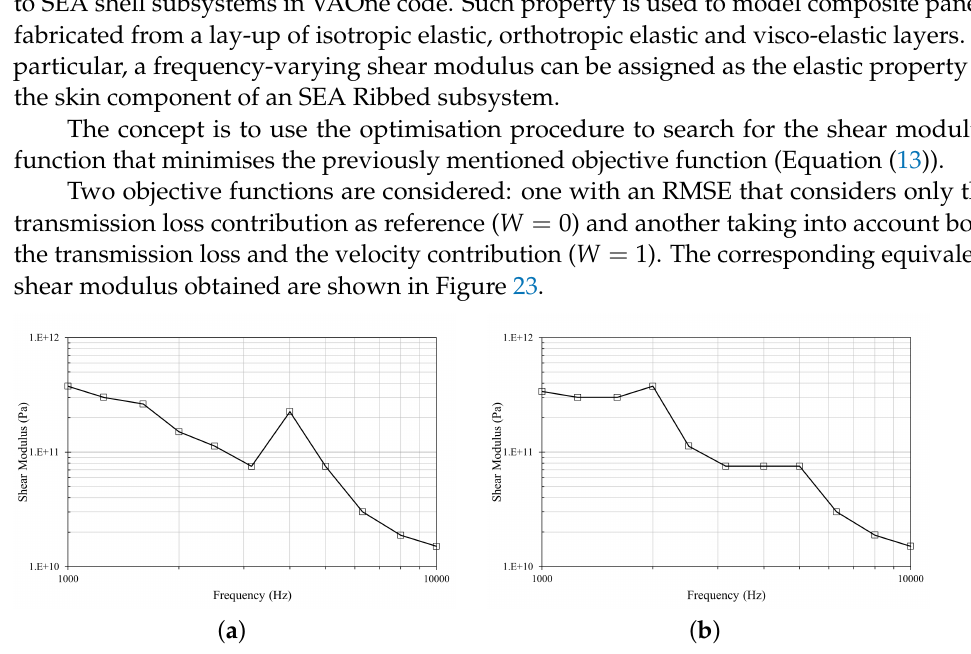
Figure 23. Equivalent panel shear modulus: ( a ) TL optimisation and ( b ) TL/velocity